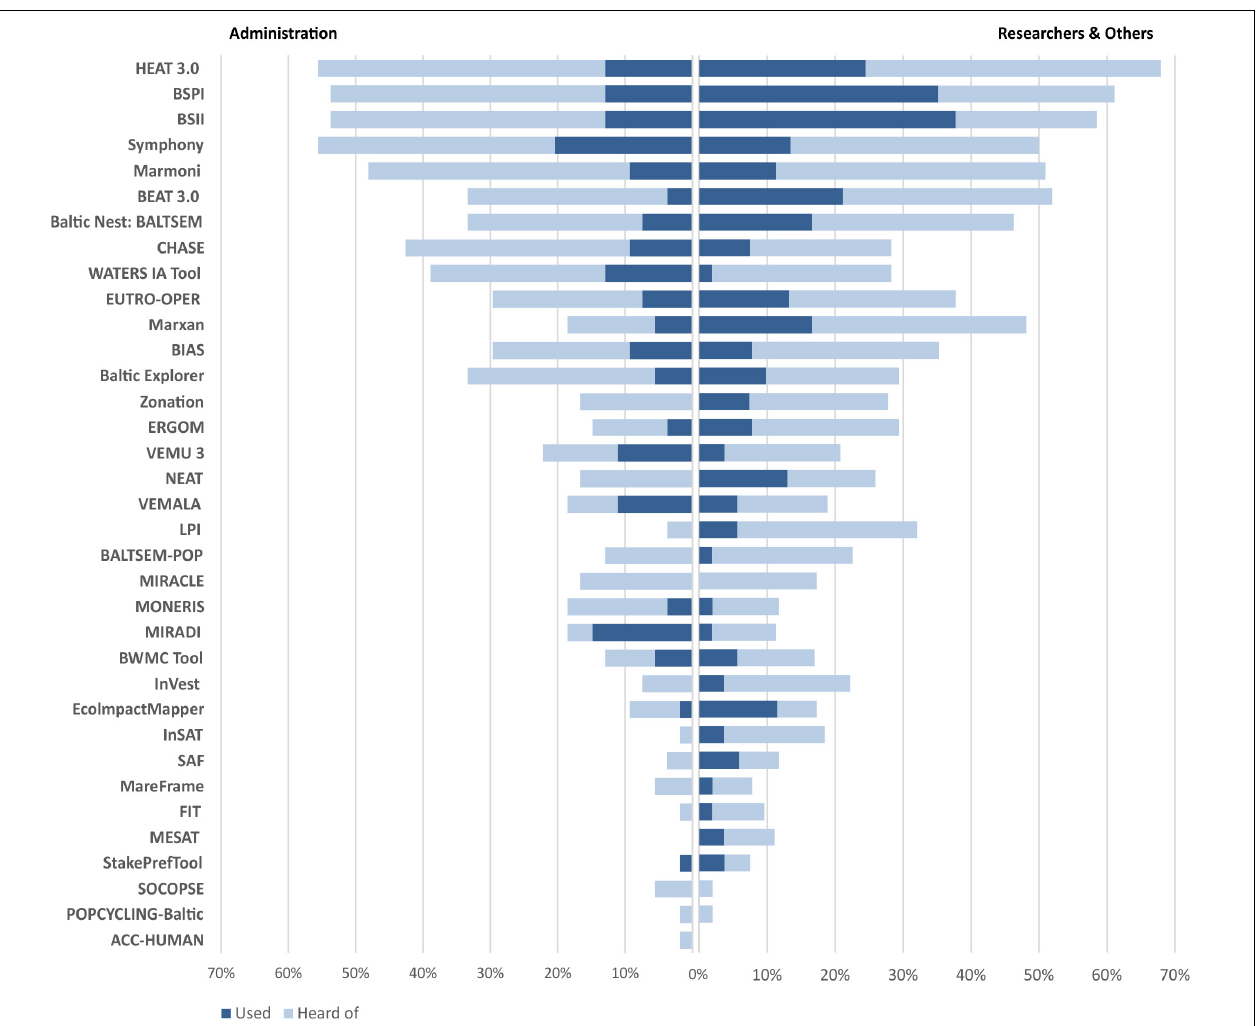
FIGURE 2 | Level of awareness and use of decision support tools (DSTs) among respondents of the stocktaking questionnaire. Results are shown separately for end-users working in public administration (Administration) and end-user working in research institutes, universities, NGOs, private companies, and others (Researchers and